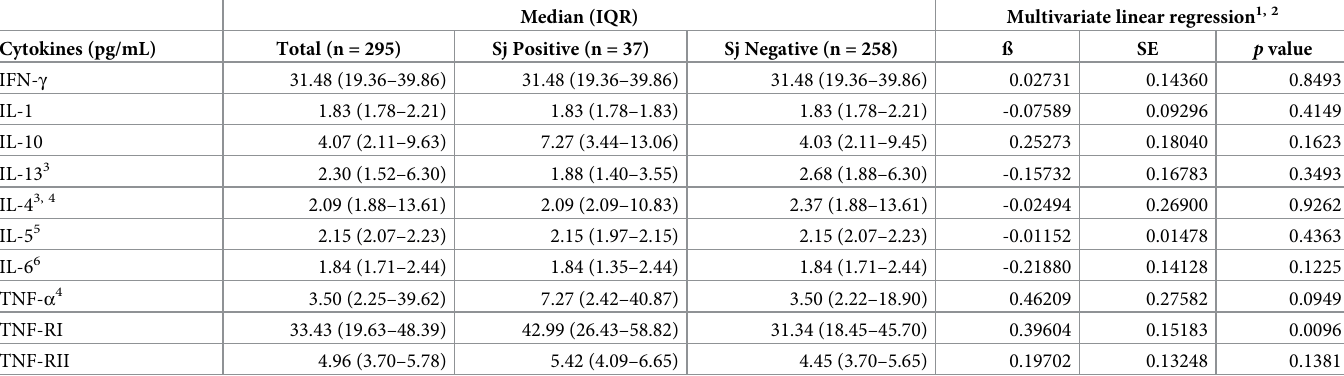
Table 2. Association between S . japonicum infection and serum cytokines. Median (IQR) Multivariate linear regression 1,